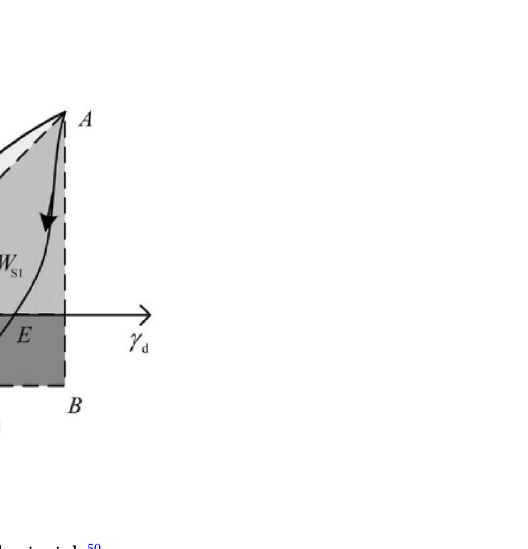
Figure 4. Diagram of the Kumar method principle 50